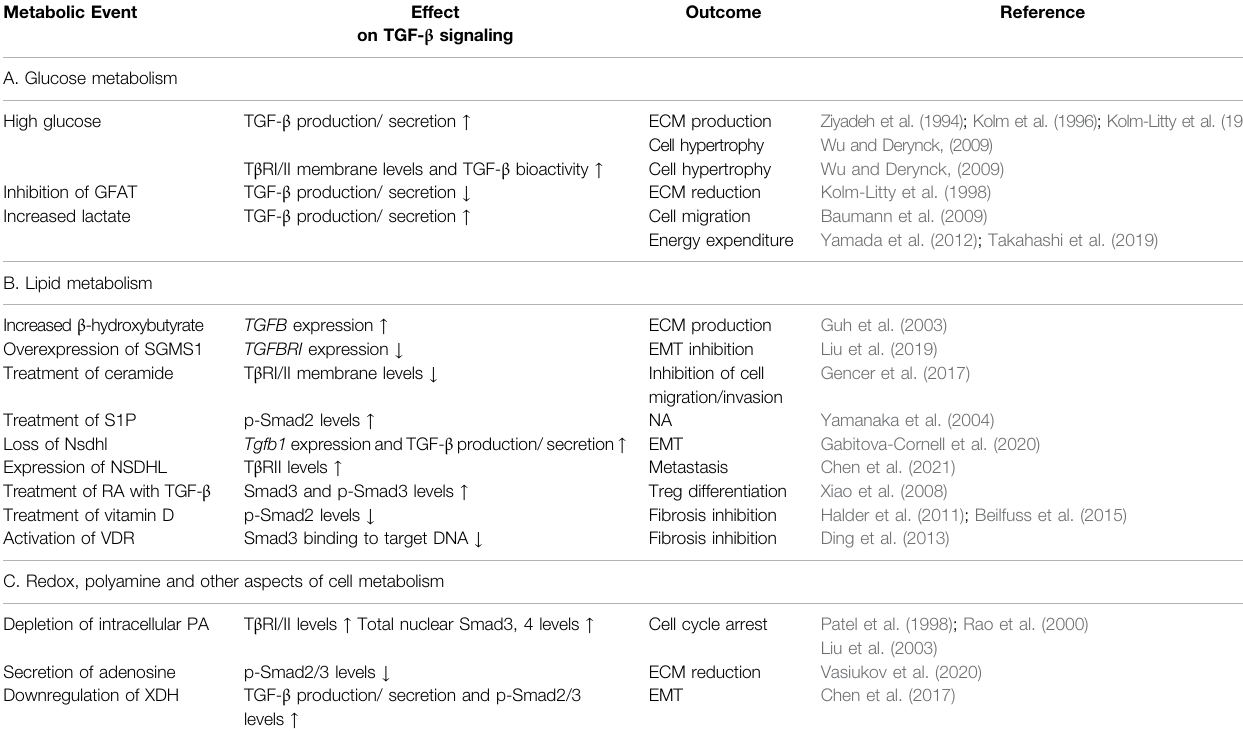
TABLE 2 | Modulation of TGF- β signaling by metabolic